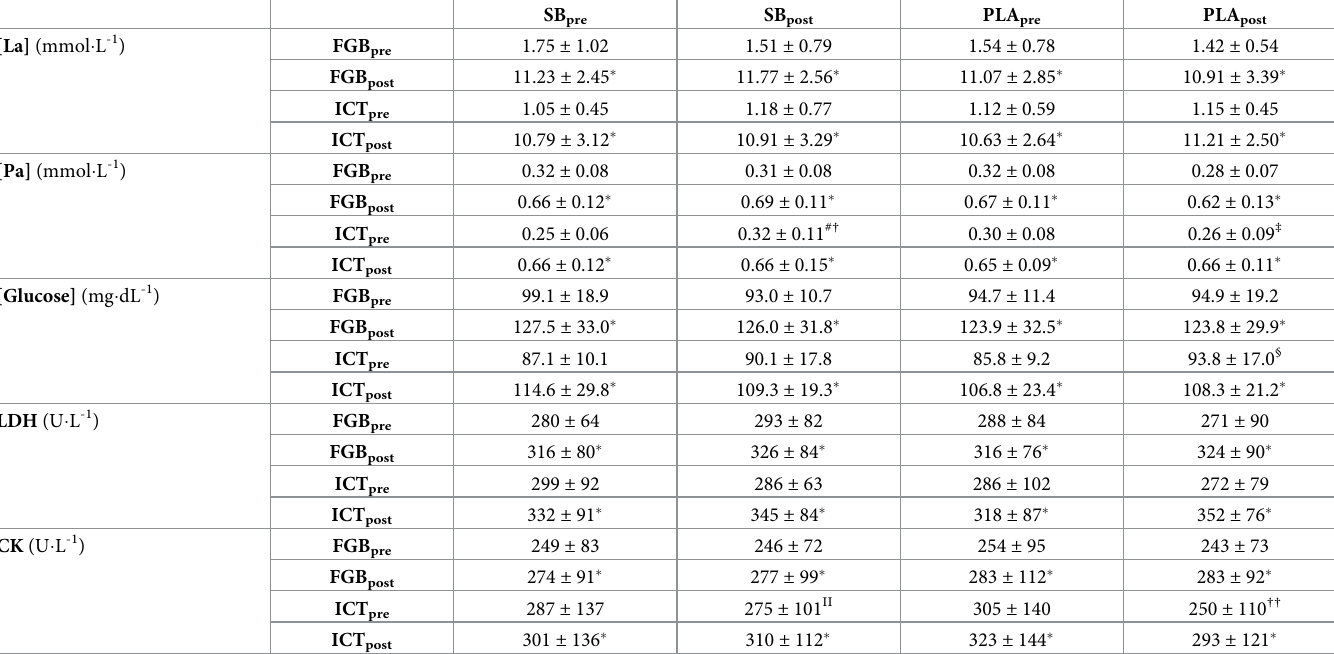
Table 3. Biochemical response to exercise tests (Fight Gone Bad and incremental cycling